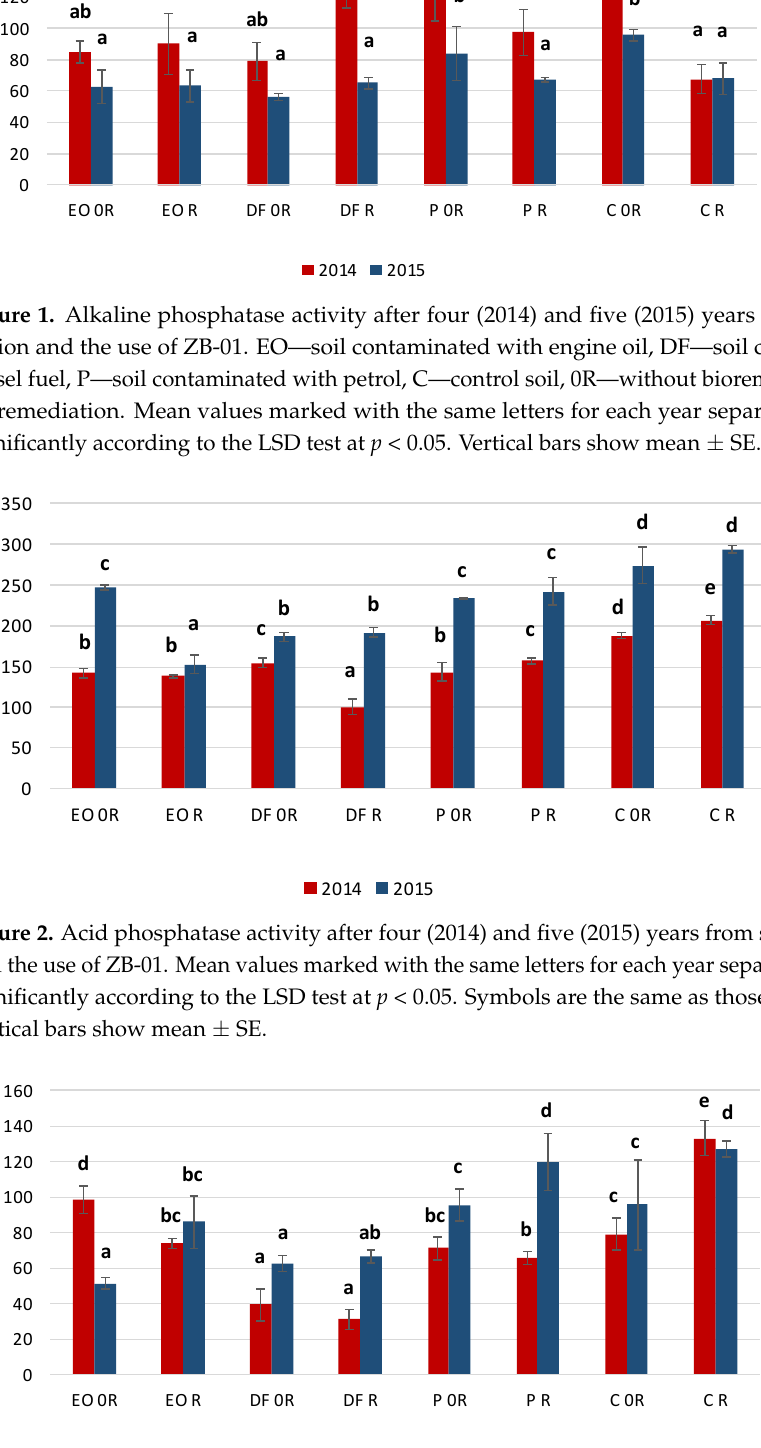
Figure 4. Urease activity after four (2014) and five (2015) years from soil contamination and the use of ZB-01. Mean values marked with the same letters for each year separately do not differ sig- nificantly according to the LSD test at p < 0.05. Symbols are the same as those used in Figure 1. Vertical bars show mean ± SE. 3.2.2. ACR Indicator Four years from the moment of soil contamination, EO in the sections without bio- preparation use contributed to an increased dehydrogenase and urease activity, which was evident from the positive ACR values (higher activity than that in the control soil), while also lowering phosphatases activity, as indicated by the negative values of the ana- lyzed ratio (Table 1). In the second year, soil enzymatic activity was found to decrease due to the presence of PDSs in the soil (both in the sections with biopreparation use and those without it).